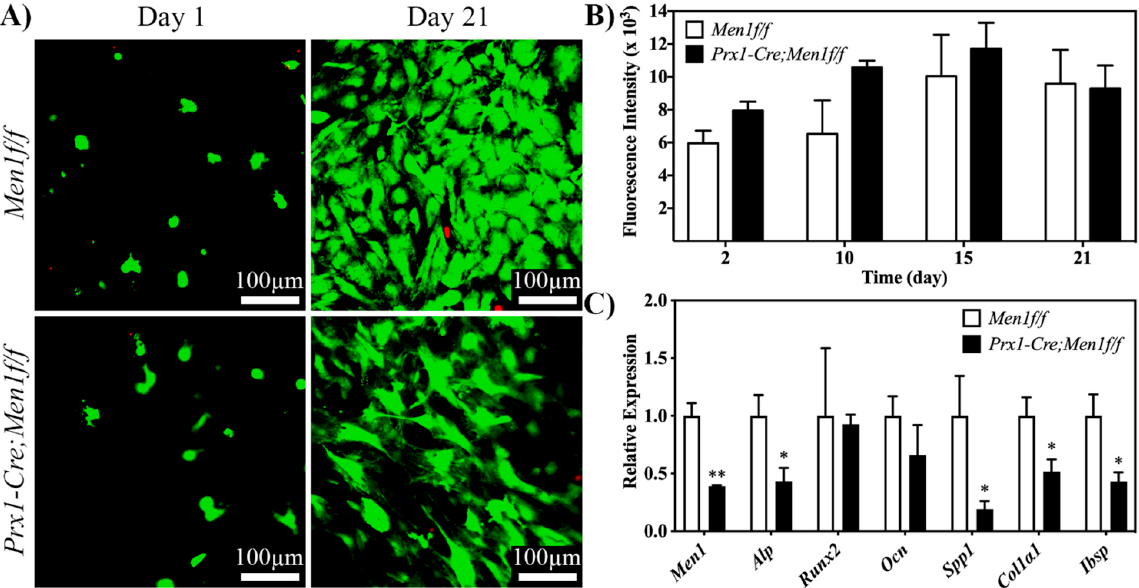
Figure 1. Viability, proliferation and osteogenic differentiation of calvarial osteoblasts from 6 month old Men1f/f and Prx1-Cre , Men1f/f mice seeded in 3D dense collagen gels under osteogenic medium in vitro. ( A ) Confocal images of calcein-AM and EthD-1-stained cells at days 1 and 21. No qualitative differences between the two groups were observed ( n = 3). ( B ) Metabolic activity of seeded cells was assessed at days 2, 10, 15 and 21 of osteogenic differentiation. Seeded gels were stained in osteogenic medium with 10% alamarBlue ® reagent, and fluorescence was determined using a microplate reader. No significant differences between the two groups were observed ( n = 3). ( C ) Expressions of Men1 , Alp , Runx2 , Ocn , Spp1 , Col1 α 1 and Ibsp , of seeded cells at day 21. Significantly (* p < 0.05 and ** p < 0.01) lower expressions of markers were observed in Prx1-Cre, Men1f/f compared to Men1f/f osteoblasts ( n =